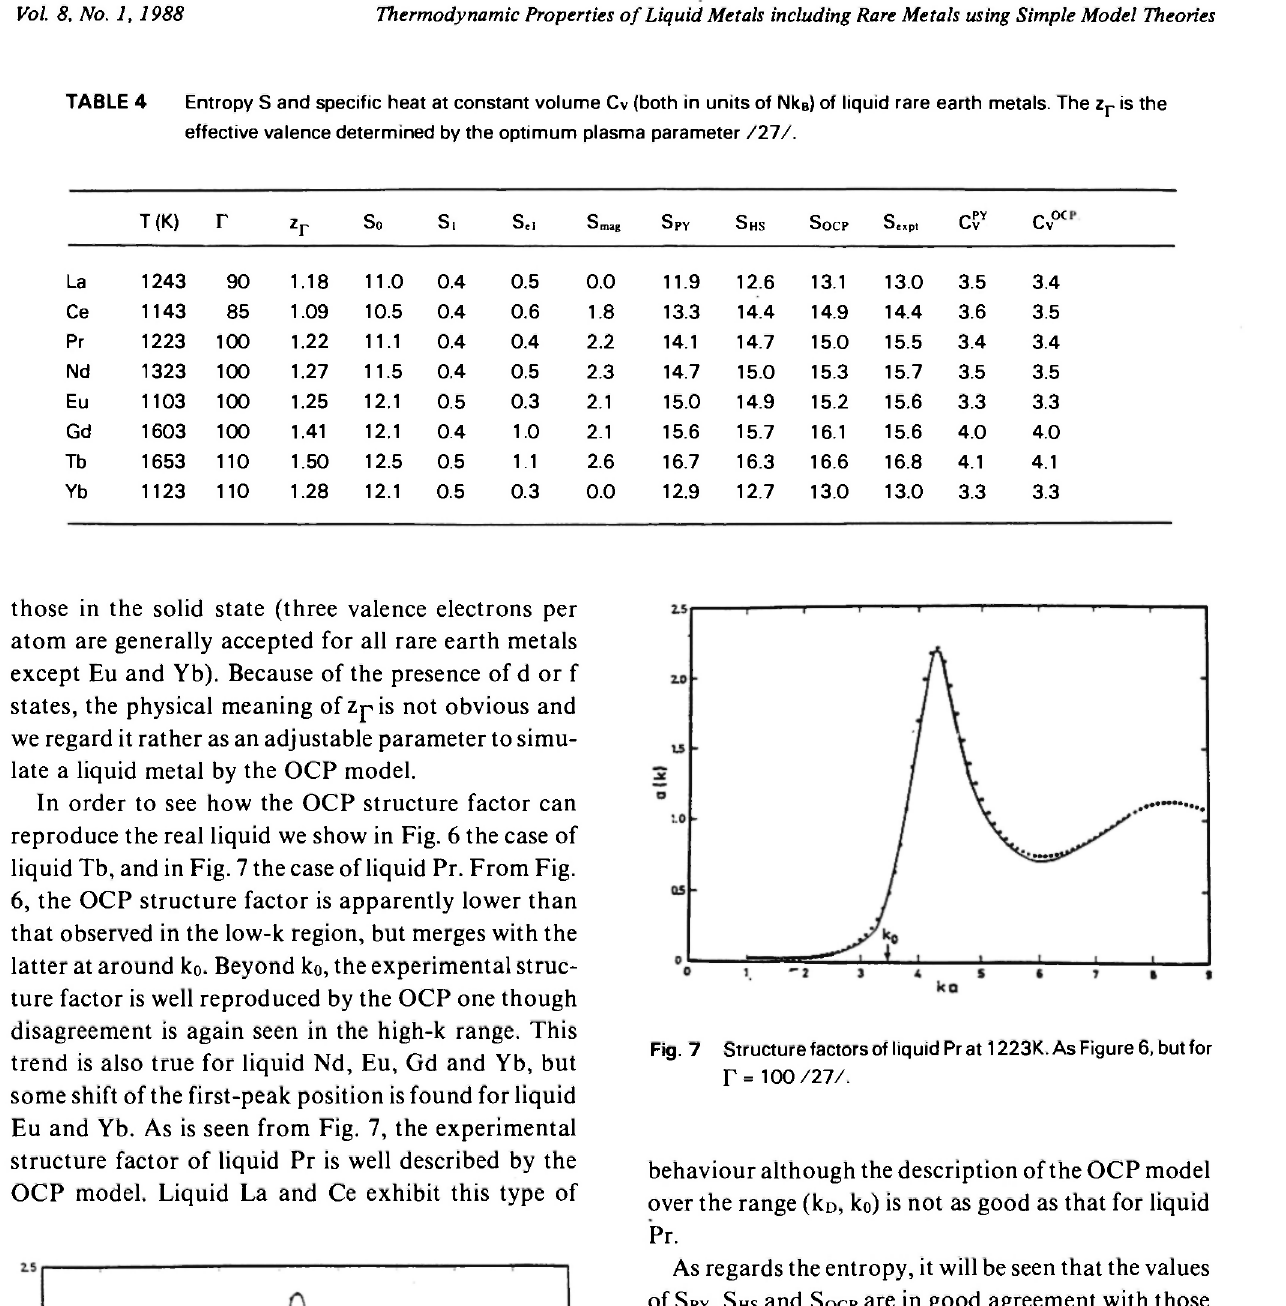
behaviour although the description of the OCP model over the range (k D , ko) is not as good as that for liquid